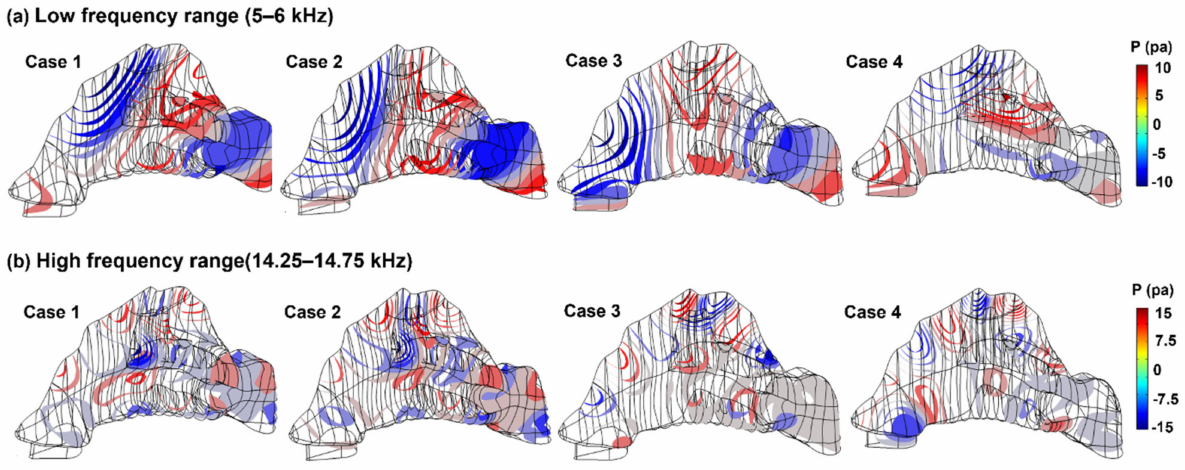
Figure 8. Comparison of acoustic pressure isosurfaces among four nasal geometries: ( a ) low- frequency range (5–6 kHz), and ( b ) high-frequency range (14.25–14.75